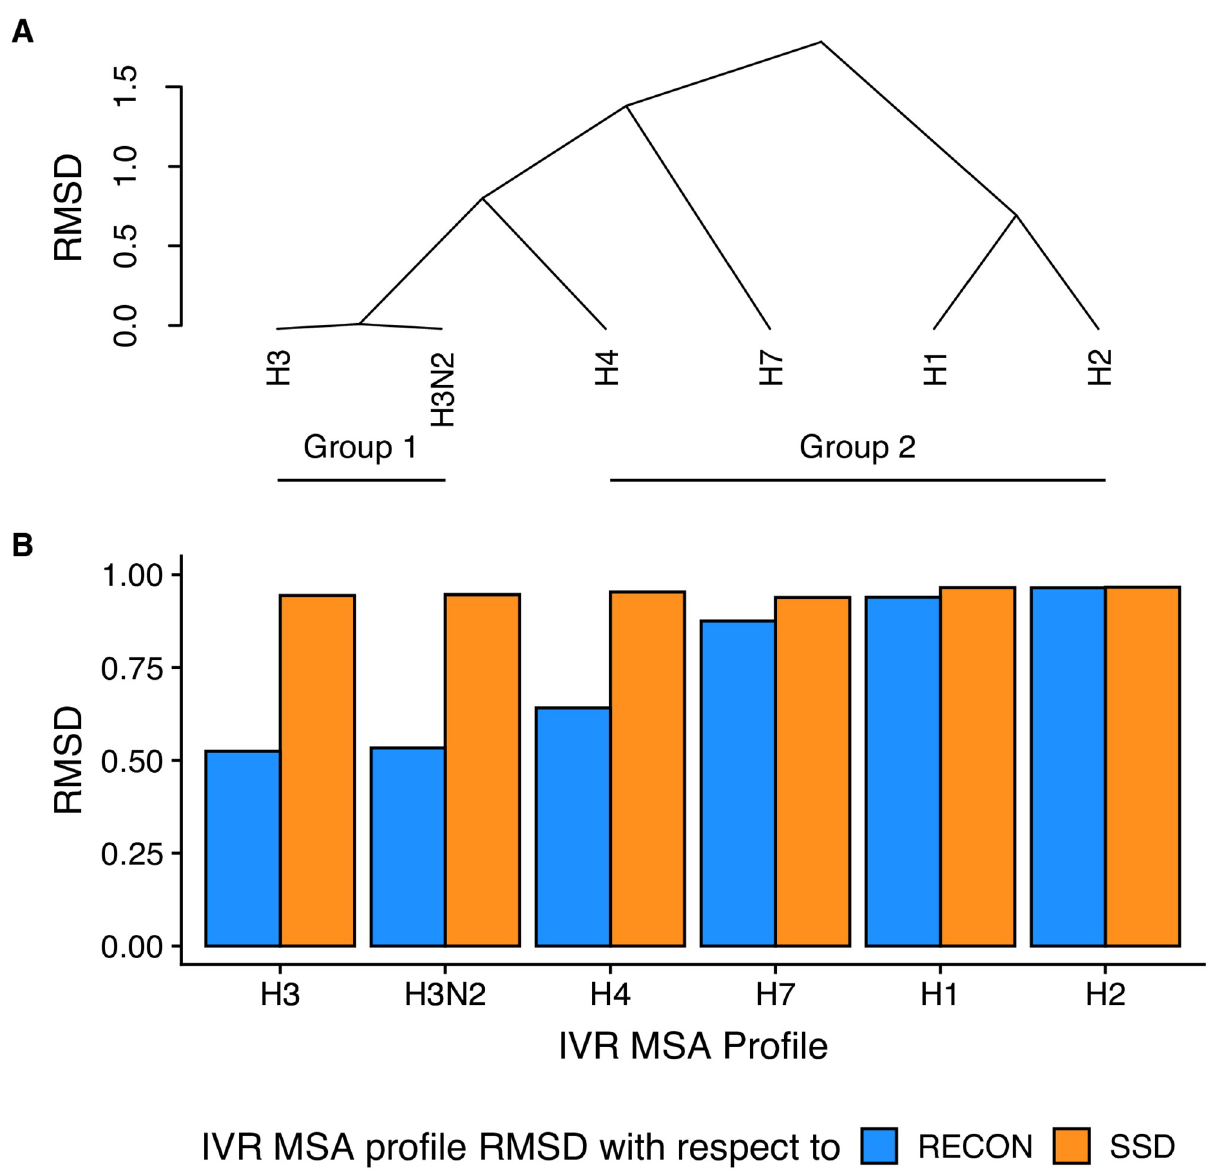
Fig 6. Root mean square deviations of residue mutation frequencies of influenza A subtypes and HA2 profiles predicted by RECON MSD and SSD. (A) Dendrogram of root mean square deviations (RMSD) of influenza A subtype HA2 profiles sorted by pairwise RMSD. The mutation frequencies derived from the multiple sequence alignment profile of each influenza A subtype was compared to all other subtypes by calculating the mean standard deviation of each aligned position’s mean sum of squared differences of all twenty amino acid frequencies with respect to each other subtype profile. Pairwise RMSD values were sorted to form clades, with the height along the y axis indicating the pairwise RMSD between each clade. (B) RMSD of each IVR subtype multiple sequence alignment (MSA) profile with respect to RECON MSD and SSD. The x axis represents each IVR subtype profile sorted as in Panel A. The y axis represents the RMSD, calculated in the same fashion as in Panel A, of each subtype profile in relation to either RECON MSD or